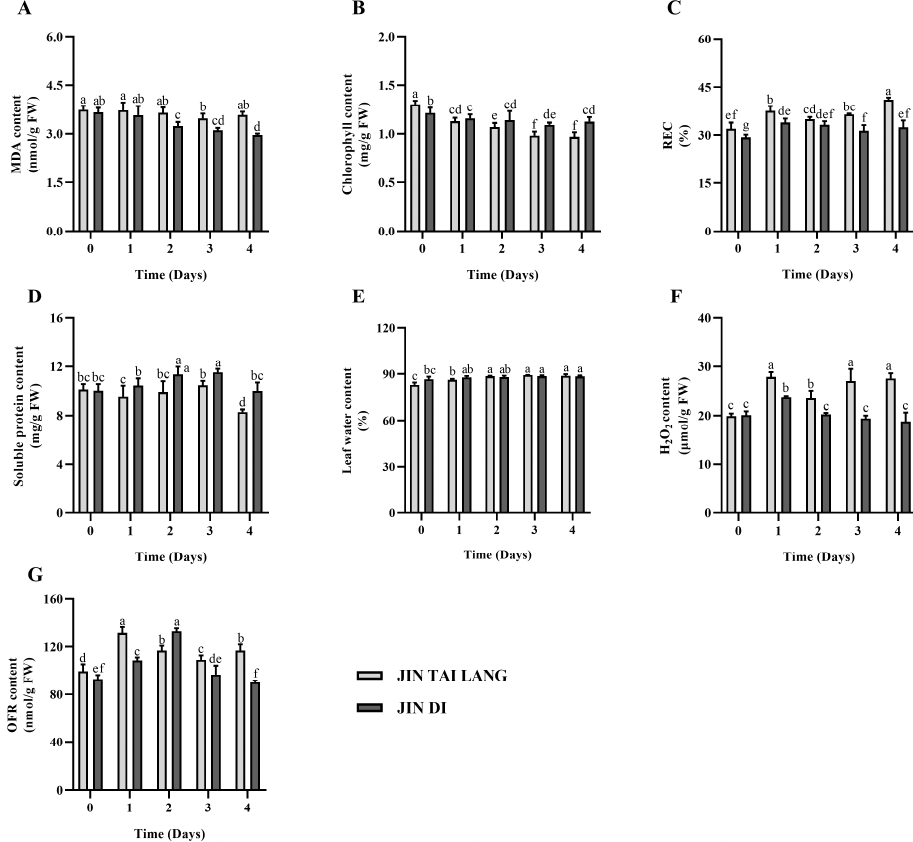
Figure 3. Physiological indexes of two different genotypes of muskmelon under HTH stress. ( A ), malondialdehyde (MDA) content; ( B ), chlorophyll content; ( C ), relative conductance (REC) (%); ( D ), soluble protein content; ( E ), leaf water content (%); ( F ), hydrogen peroxide (H 2 O 2 ) content; ( G ), superoxide anion (OFR) content. Different letters indicate significant differences according to Duncan’s multiple range test at p < 0.05 using a one-way ANOVA. Values are represented as the means ± SD ( n = 4).